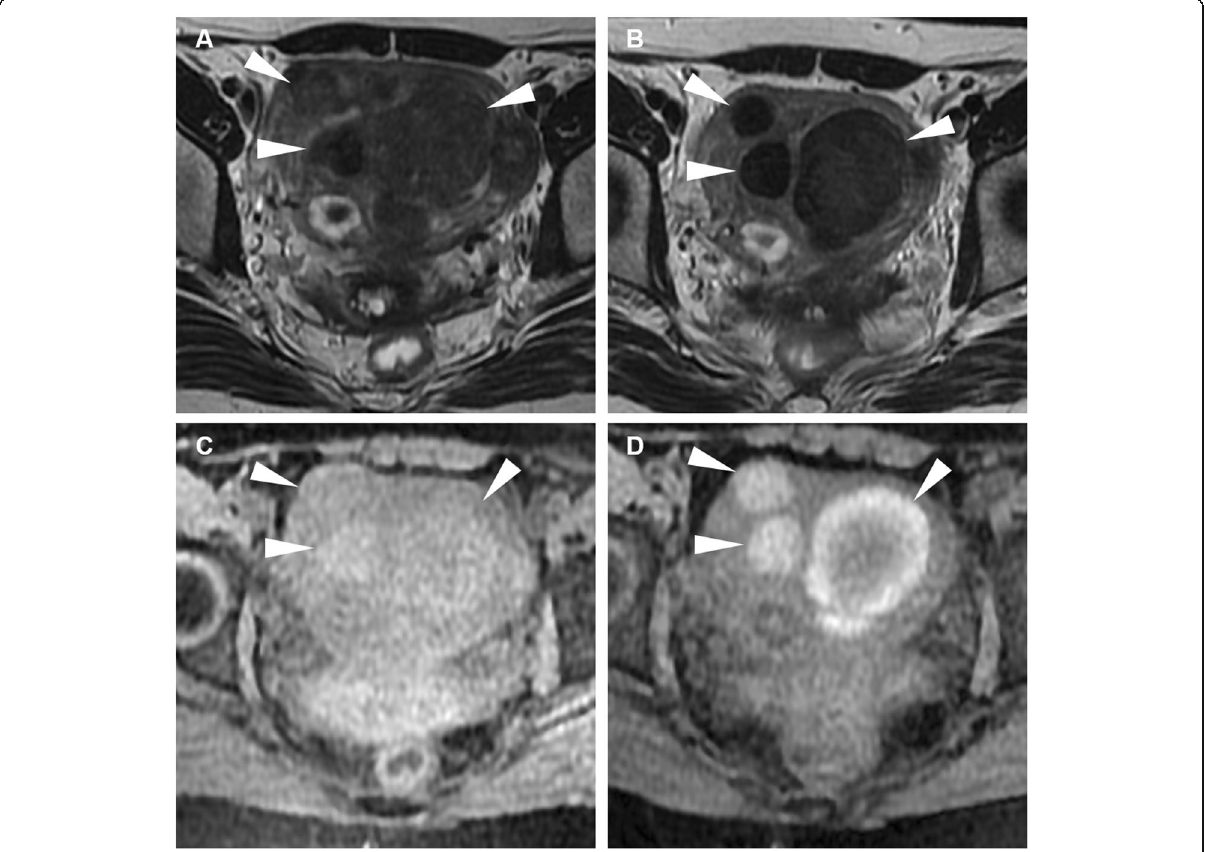
Fig. 6 Multiple leiomyomas in a 48-year-old woman with pelvic pain and fever after uterine fibroid embolisation (UFE). Pre-treatment oblique-coronal T2- weighted ( a ) and fat-suppressed T1-weighted ( c ) images show multiple intramural leiomyomas, with respectively low and intermediate signal intensity (arrowheads). After bilateral UFE, on oblique-coronal T2-weighted ( b ) and fat-suppressed T1-weighted ( d ) images, the leiomyomas (arrowheads) show low T2 signal intensity and peripheral or homogeneous high signal intensity on fat-suppressed T1-weighted image reflecting internal haemorrhagic